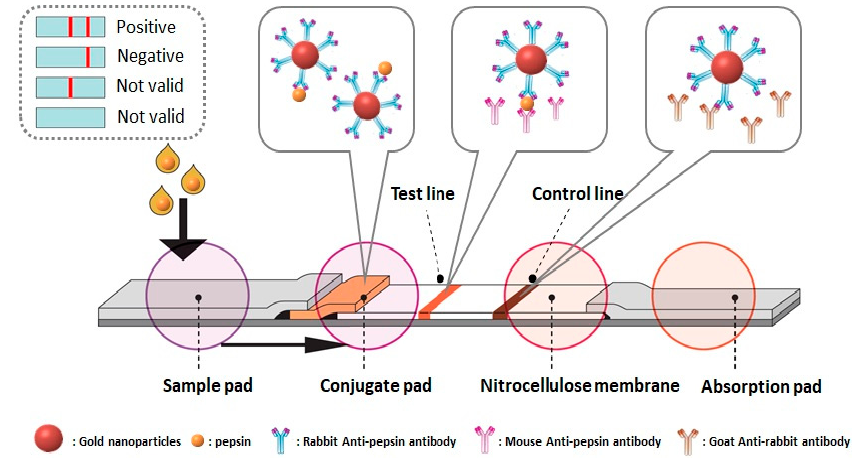
Figure 1. The schematic diagram for the detection process of the pepsin immunochromatographic strip. To start a test, we apply a sample containing the analyte (i.e., pepsin) to the sample pad, and it subsequently migrates to the other parts of the strip. At the conjugate pad, pepsin is captured by gold nanoparticle (AuNP)-antibody conjugate. This pepsin-binding conjugate reaches the nitrocellulose membrane and moves under capillary action. At the test line, the pepsin-binding conjugate is captured by another antibody (monoclonal) that is primary to pepsin. Excess AuNP-antibody conjugate will be captured at the control line by secondary antibody. The colorimetric intensity at the test line, which corresponds to the amount of pepsin in saliva samples, is captured using a digital camera and analyzed using ImageJ software. The appearance of color at the control line ensures that a strip is functioning